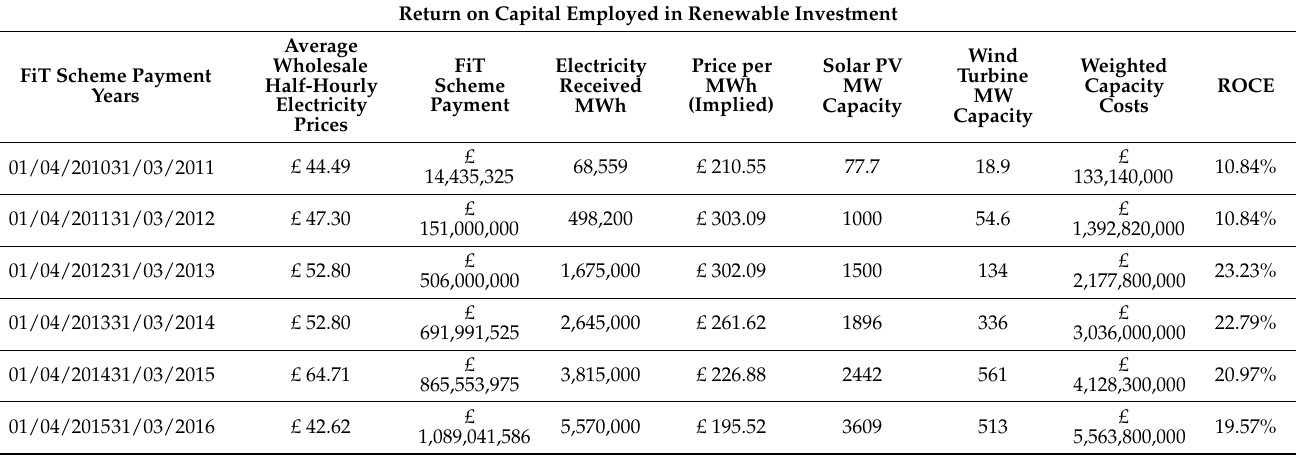
Table 2. Return on capital employed for renewable generation. Return on Capital Employed in Renewable